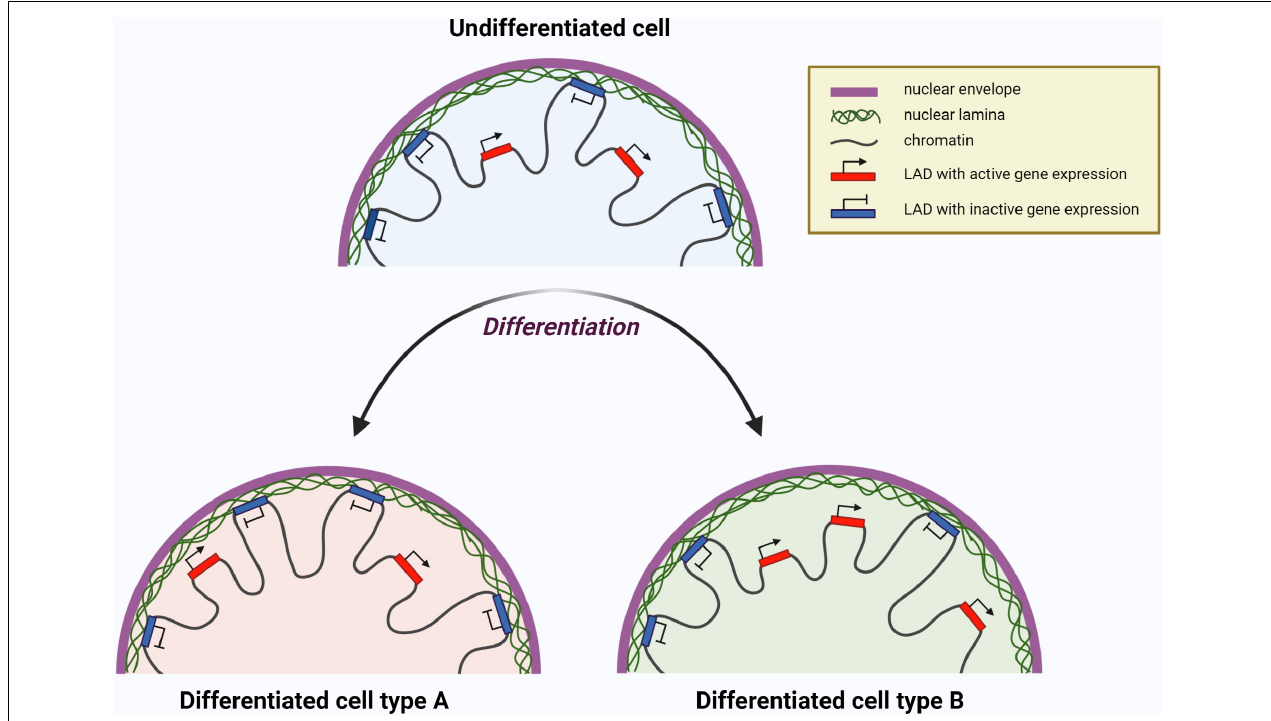
FIGURE 7 | Chromatin reorganization resulting in change of gene expression profile of a cell during differentiation. Lamina-associated domains (LADs) attached to nuclear lamina are transcriptionally inactive, whereas LADs unattached to lamina are available for transcription. The set of LADs is unique for certain differentiated cells and different from undifferentiated cells. Here two hypothetical differentiated cell types are shown as "Differentiated cell type A" and "Differentiated cell type B" having different LADs with transcriptionally active (red) and inactive (blue) genes. Created with